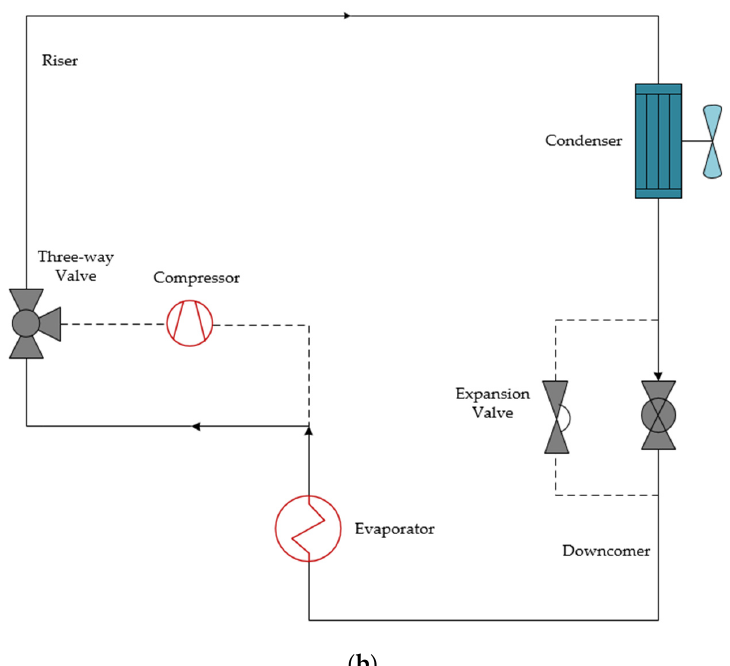
Figure 12. Two modes of operation for combined cooling systems proposed by HAN et al.: ( a ) VC mode; ( b ) TS mode [64,65].